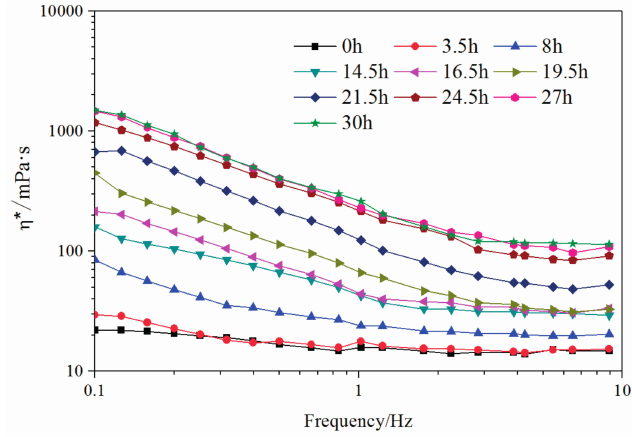
Figure 2. Complex viscosity vs. frequency of polymer gels at different gelation